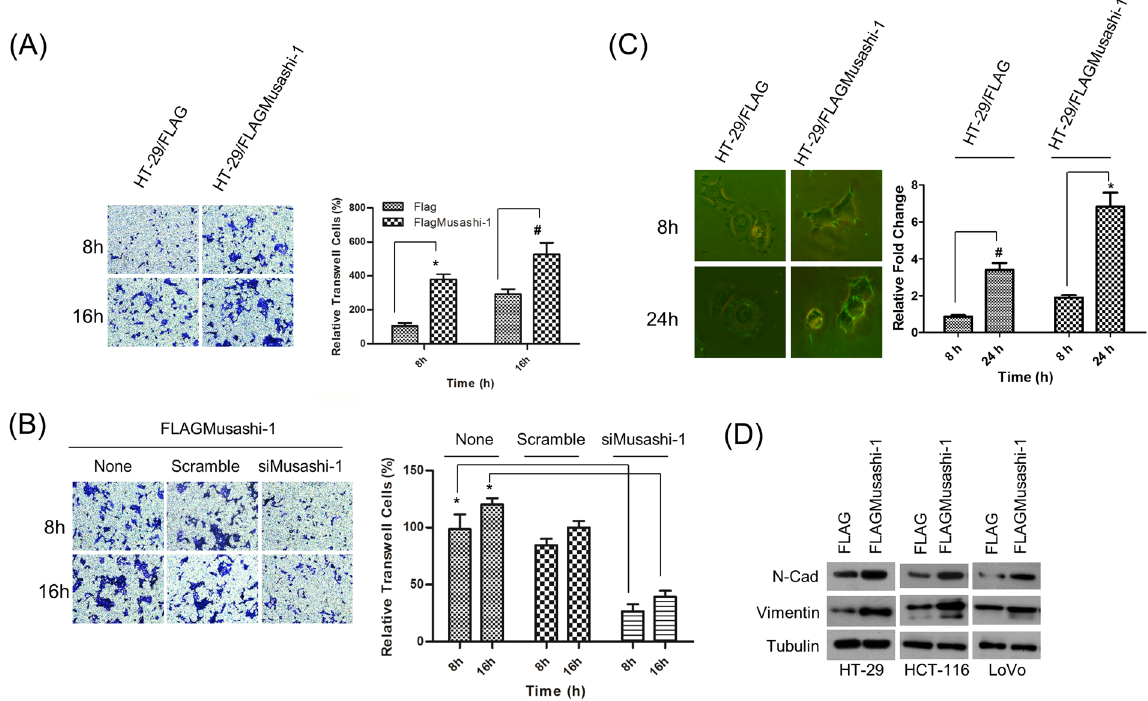
Figure 2. Musashi-1 promotes cell migration. ( A ) Increased migration in Musashi-1-overexpressing HT-29 cells. HT-29/FLAG and HT-29/FLAGMusashi-1 stably expressing HT-29 cells were subjected to the migration assay in 8 μ m transwell chambers. Cells were fixed and stained by crystal violet after 8 and 16 h incubations (left panel). Relative migration was quantified, and the results are shown as a bar chart. Error bars indicate the mean ± SD from three independent experiments. * p < 0.01, # p < 0.05 (right panel). ( B ) Cell migration is Musashi-1-dependent. HT-29/FLAGMusashi-1 cells were pretreated with Musashi-1-specific or scrambled siRNAs and then subjected to the transwell assay. Cells in the transwells were fixed and stained at the indicated time points (left panel). The results of the cell migration assay were quantified. Error bars indicate the mean ± SD from three independent experiments. * p < 0.01 (right panel). ( C ) Degradation of extracellular material by HT-29 cells overexpressing Musashi-1. HT-29/FLAGMusashi-1 and control HT-29/FLAG cells were plated on FITC-gelatin-coated coverslips. Cells were fixed at the indicated time points and images acquired using Olympus cellSens software v1.12 (left panel). Images were analysed for clear zone areas by ImageJ software. Clear zone areas were measured, normalized, and are presented as a bar chart. Error bars indicate the mean ± SD from three independent experiments. * p < 0.01, # p < 0.05 (right panel). ( D ) Increased expression of metastasis-associated genes. Total cell lysates of HT-29, HCT-116, and LoVo cells/FLAG and HT-29, HCT-116, and LoVo cells/FLAGMusashi-1 cells were collected in RIPA buffer with protease and phosphatase inhibitors. Expression of N-cadherin (N-Cad) and vimentin was analysed by immunoblotting with specific